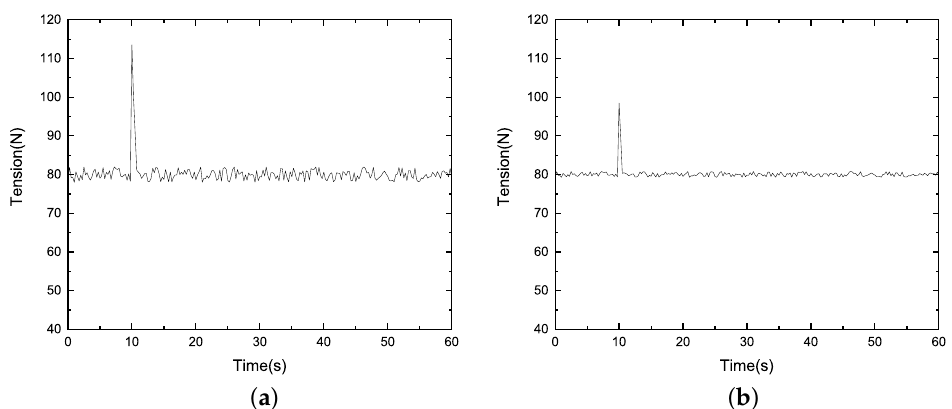
Figure 9. Tension local magnification curve ( a ) of the PID control and ( b ) SP-ADRC